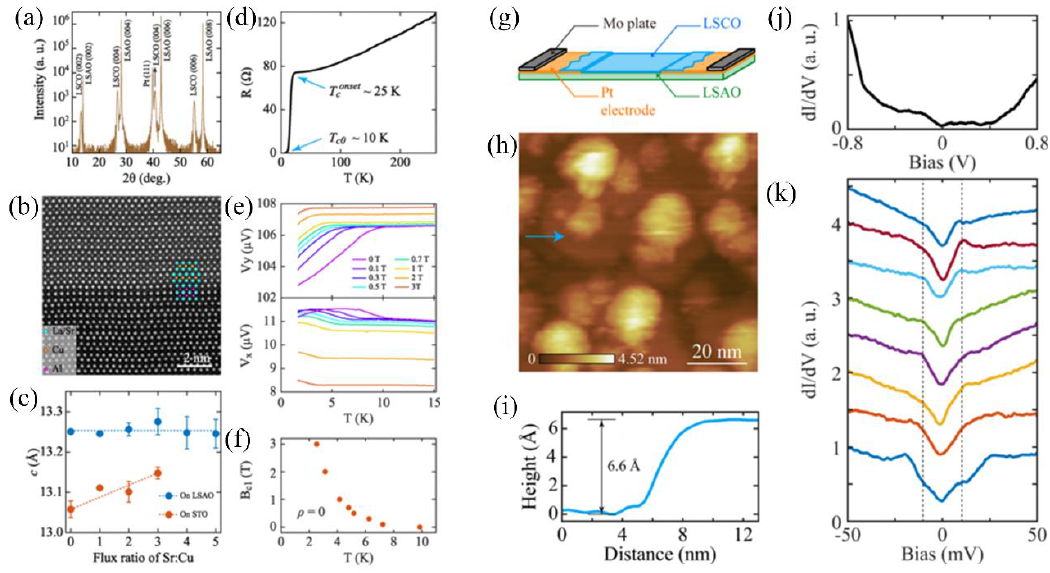
Figure 4. ( a ) XRD of the LSCO film. ( b ) STEM image of the LSCO/LSAO heterointerface. ( c ) Com- parison of c − axis lattice parameters vs. flux ratios of Sr:Cu. ( d ) R − T curve of the LSCO/LSAO sample. ( e ) Imaginary and real parts of mutual inductance vs. T under different magnetic fields. ( f ) B c1 vs. T of LSCO films. ( g ) Schematic diagram of the LSCO film deposited on the Pt electrode pre-patterning LSAO substrate. ( h ) STM topography of the LSCO/LSAO sample. ( i ) Line profile along the blue arrow in ( h ). ( j ) Large- and ( k ) Low − energy − scale d I /d V spectrum in the LSCO/LSAO film. Adapted with permission from Ref. [52]. Copyright 2021, American Chemical Society.